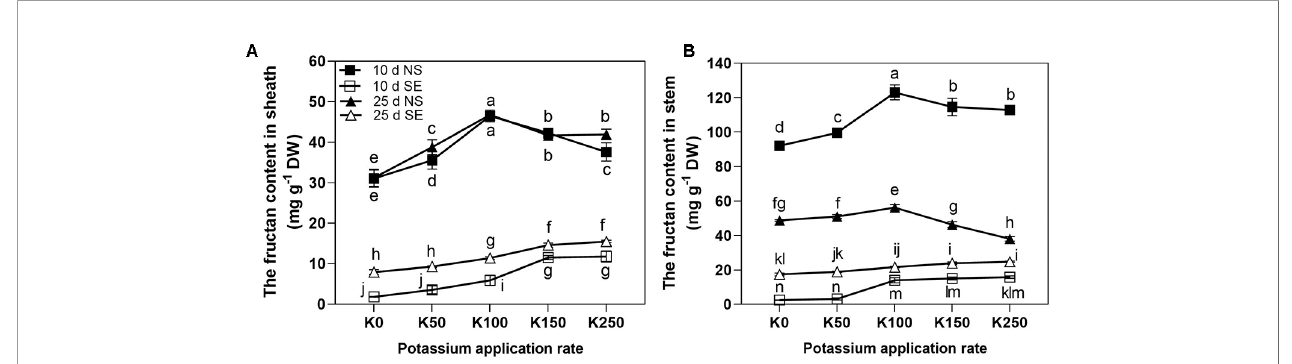
FIGURE 5 | The fructan contents in sheath (A) and stem (B) under different treatments. The error bars stand for standard deviations of the means of fi ve independent biological replicates. For each trait, different letters represent signi fi cant difference from each other according to three-way repeated measures ANOVA followed by least signi fi cant difference (LSD) multiple comparison ( P < 0.05). NS: no shading treatment; SE: shading from the 1st day to the 10th day after anthesis (shading at early fi lling stage for 10 days, SE); Five potassium rate: 0 (K0), 50 (K50), 100 (K100), 150 (K150), and 250 (K250) mg K 2 O kg -1 soil in the form of KCl.